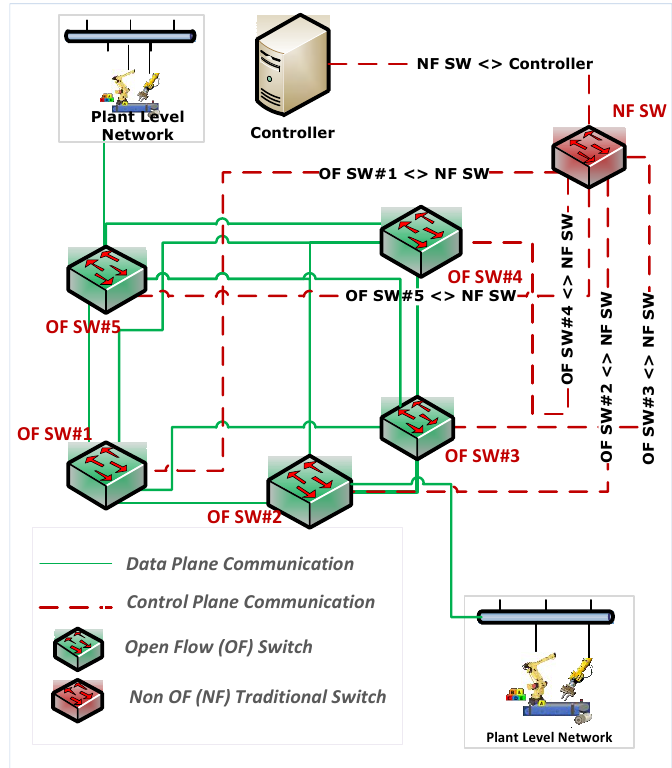
Figure 7. Network setup in Mininet.